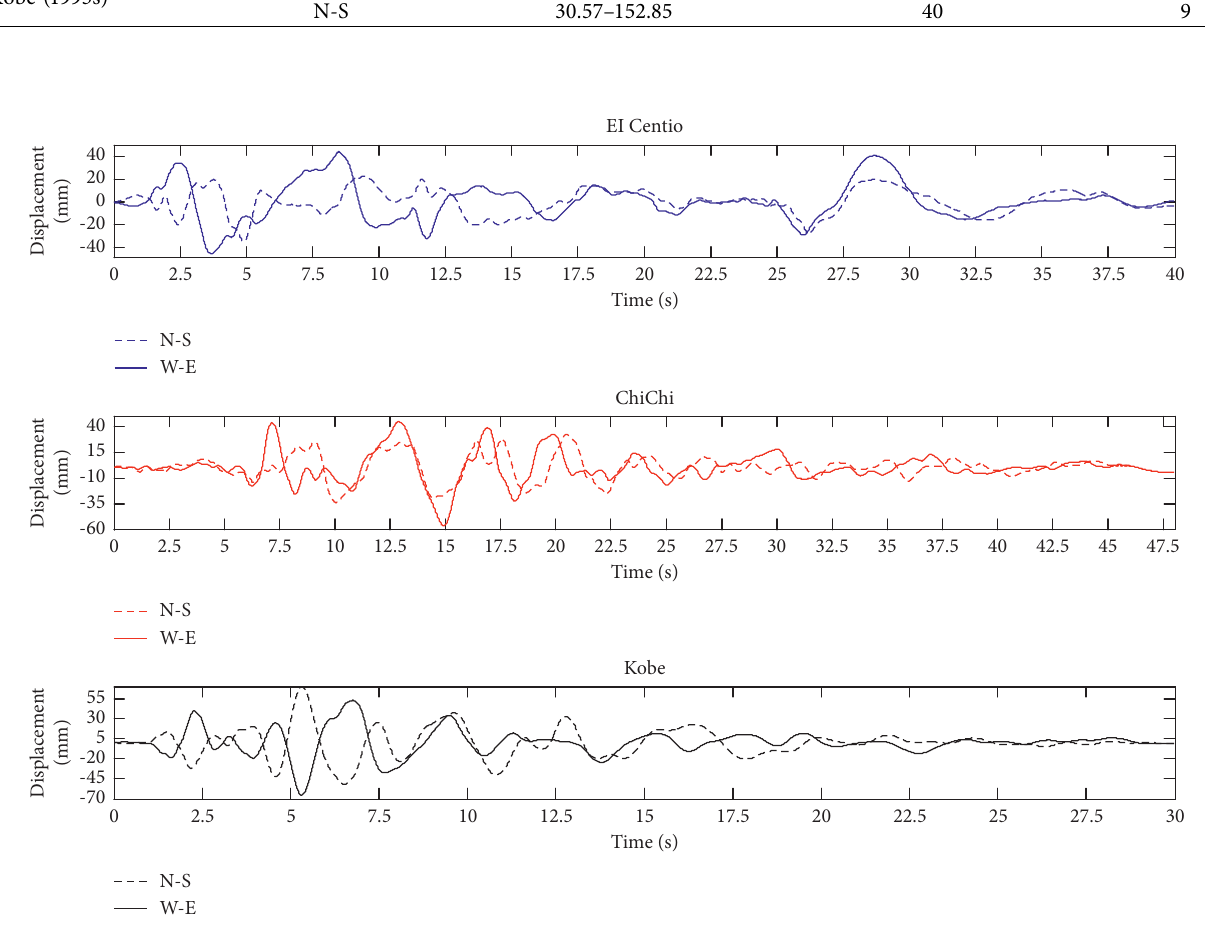
Figure 2: The shaking table under displacement-controlled